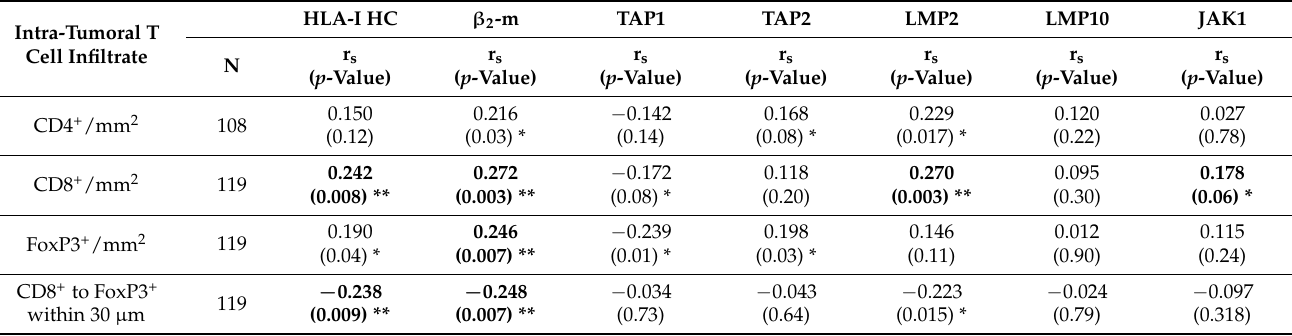
Table 5. Bivariable Correlation of the Expression of the HLA-I HC, β 2 -m, APM Components and JAK1 with the Intra- Tumoral T Cell Infiltrate.